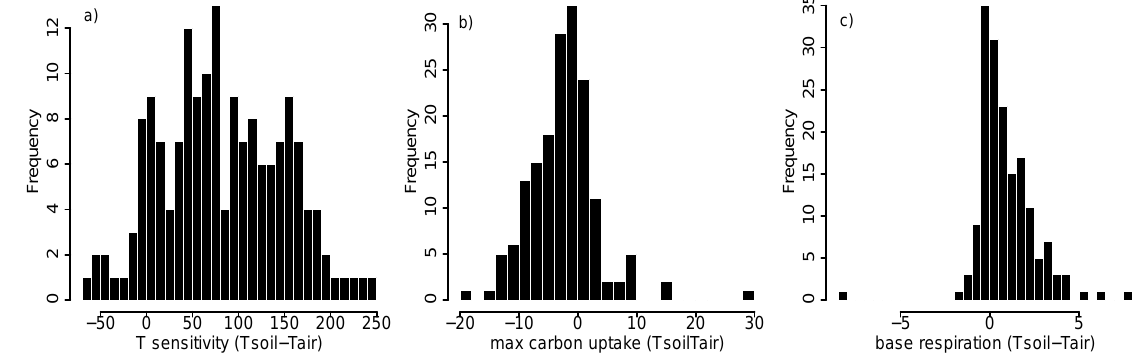
Fig. 13. Differences in the estimates of the temperature sensitivity [ ◦ C] (a) , maximum carbon uptake rate [µmolCm − 2 s − 1 ] (b) and base res- piration [µmolCm − 2 s − 1 ] (c) using soil and air temperature across FLUXNET sites. The histogram shows the differences of the parameters derived with air and soil temperature across FLUXNET